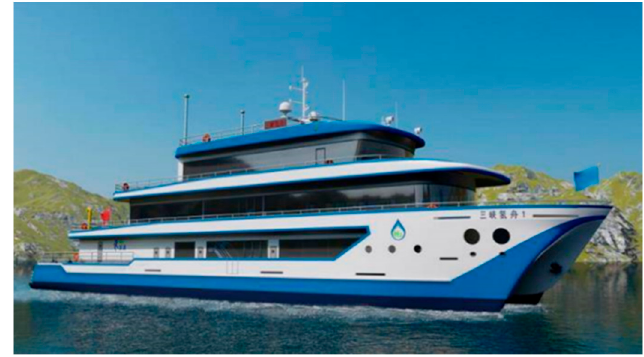
Figure 36. The ship “San Xia Qing Zhou 1” [165,166].